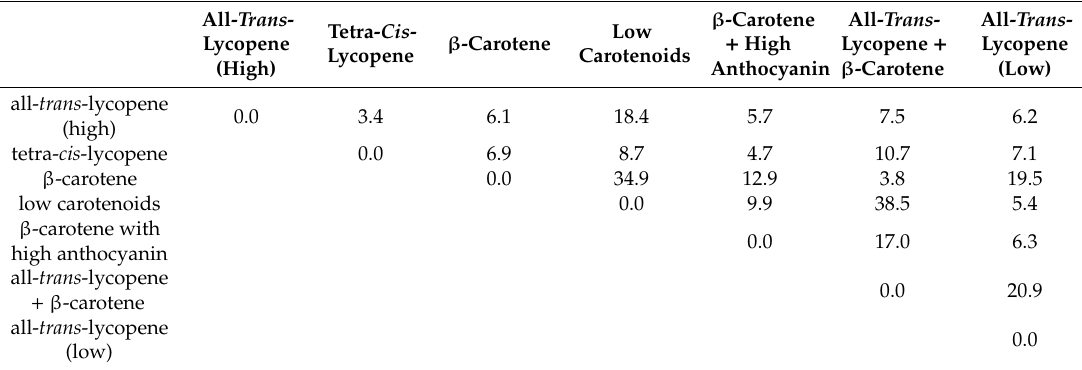
Figure 4. Soft independent modelling of class analogy (SIMCA) 3D class projections using the information in the 1370–1670 cm − 1 region. Table 1. SIMCA inter-class distances among four groups.